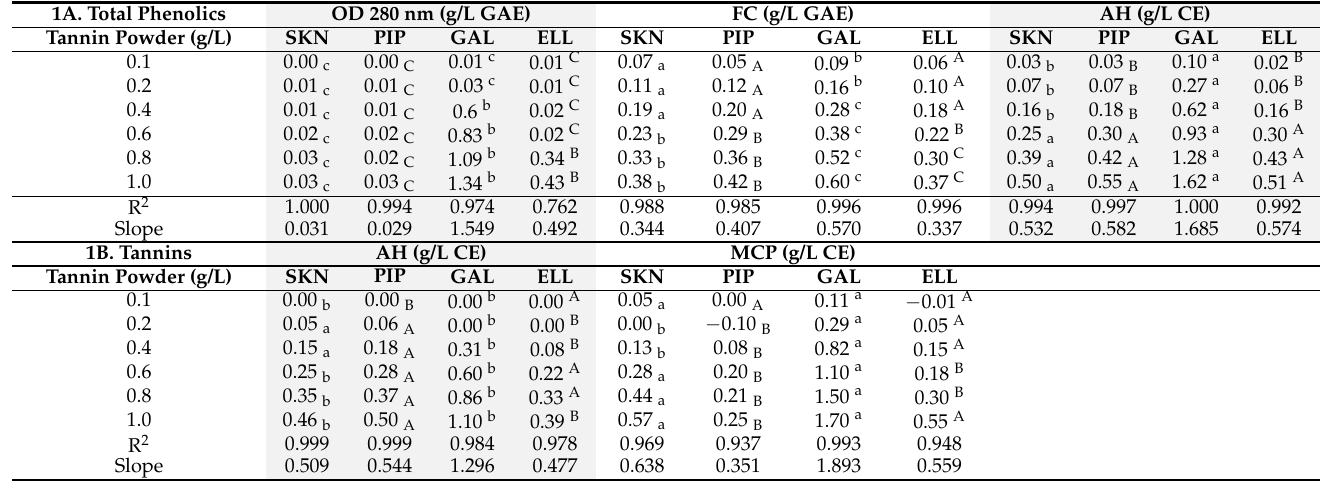
Table 1. Calibration of total phenolics (1A) and tannins (1B) with UV-vis assays, lack of fit, and ANOVA results. Legend: Optical density 280 nm (OD 280 nm); Folin–Cioc â lteu (FC); Adams– Harbertson (AH); Methylcellulose (MCP); grape skin (SKN); grape seed (PIP); gallotannin (GAL); ellagic tannin (ELL); R 2 , coefficient of